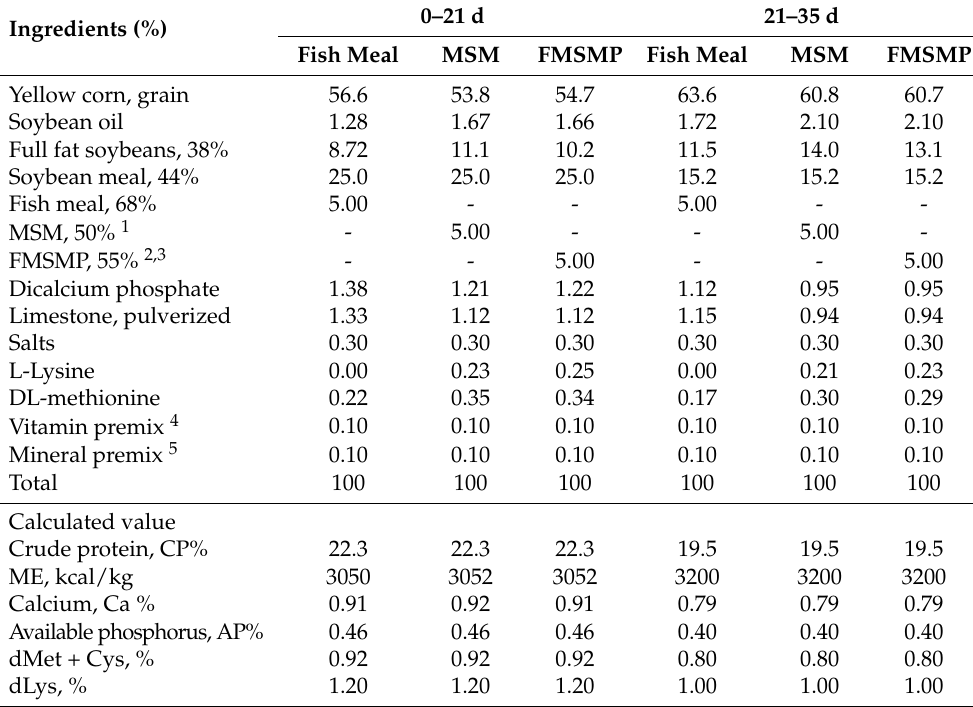
Table 1. Composition of experiment basal